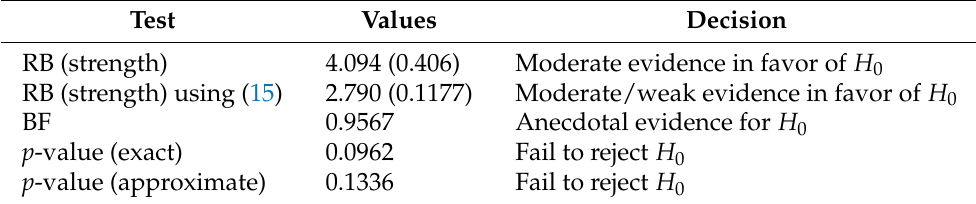
Table 2. Test results of Example 2.